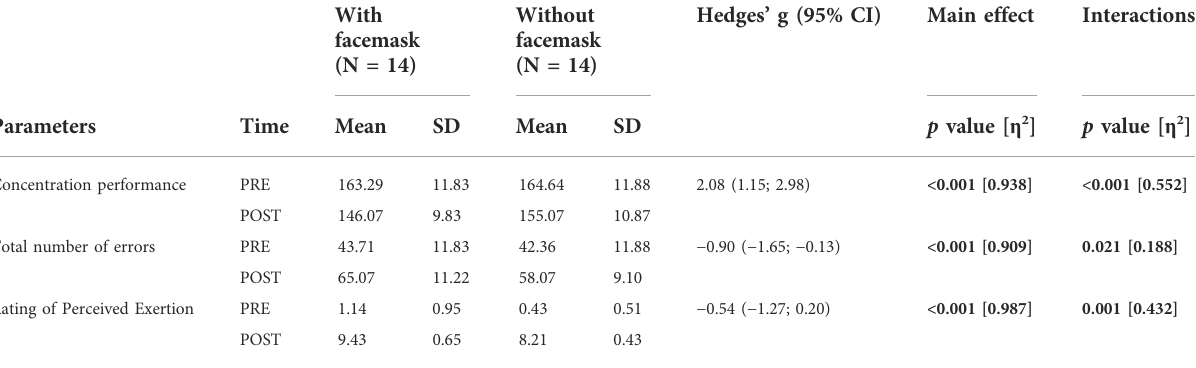
TABLE 2 Comparison of cognitive function following the MSFT, conducted while wearing or not a facemask.